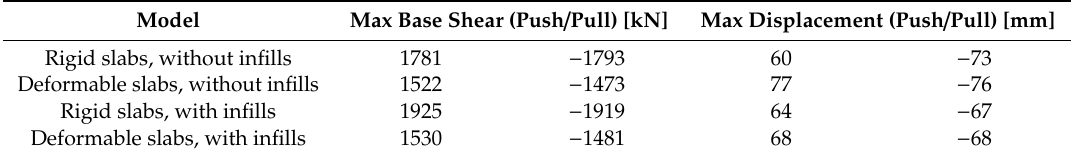
Figure 5. Pushover curves. Table 2. Maximum base shear and displacements obtained in numerical pushover analyses on different models.